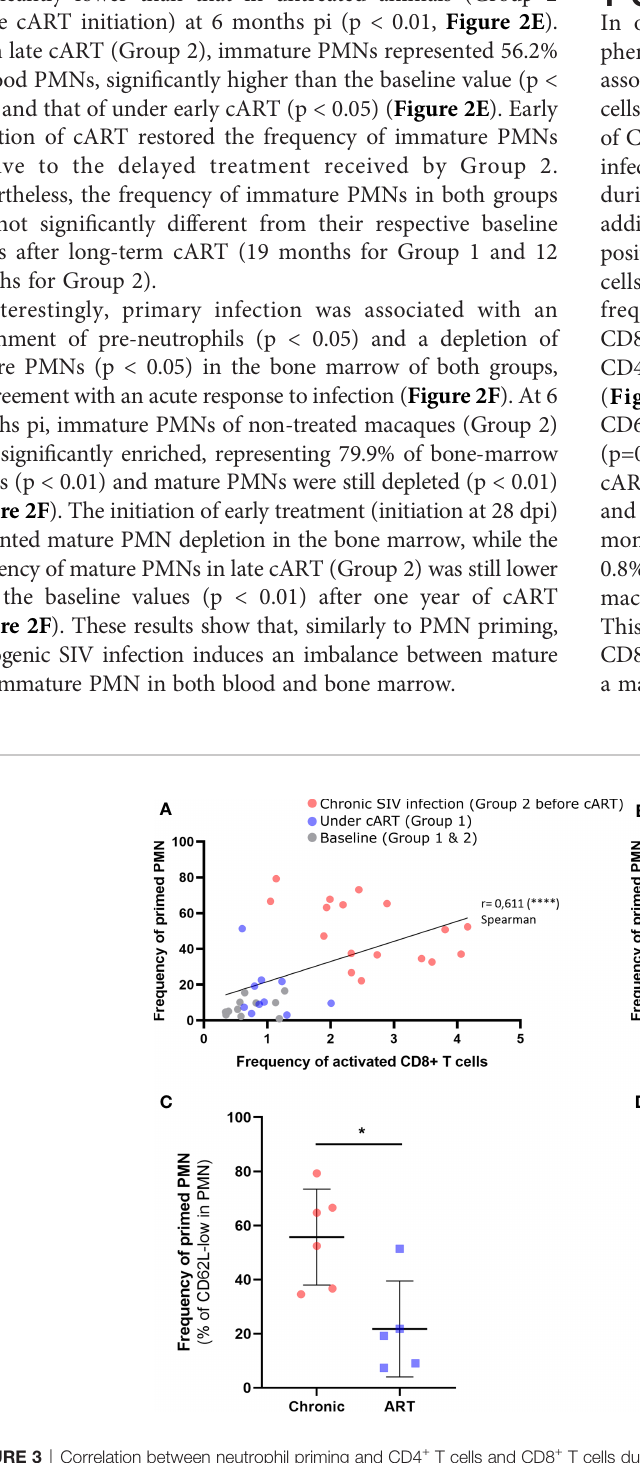
FIGURE 3 | Correlation between neutrophil priming and CD4 + T cells and CD8 + T cells during SIV infection. (A) Correlation between the frequency of CD62L-low PMNs and that of HLADR + CD8 + T cells (p < 0.0001). (B) Correlation between the frequency of CD62L-low PMNs and that of HLADR + CD4 + T cells. The colors correspond to chronically SIV-infected animals (red; 57dpi, 3 months pi and 6 months pi), animals treated early with cART (purple; 6 months pi and 9 months pi), and baseline (gray). (C, D) Comparison of PMN subpopulation frequencies and activated CD8 + T-cell frequencies between chronically infected (6 months pi) and treated animals (7 months pi, 6 months pART). Mann Whitney test for unpaired comparisons with *p < 0.05, ****p < 0.0001. ns, non-signi fi